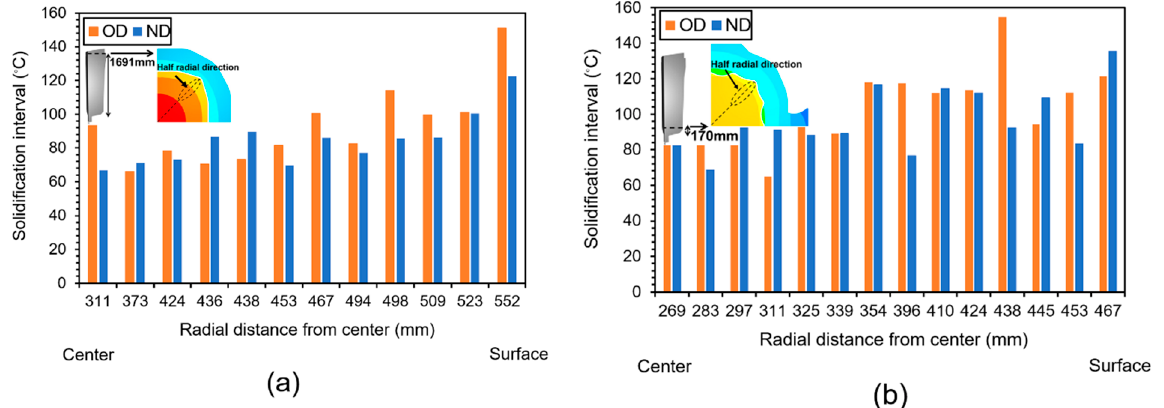
Figure 14. Solidification interval °C in OD and ND at ( a ) A half radial distance from the ingot wall at the hot top area (a height of 1691 mm from the bottom), ( b ) A half radial distance from the ingot wall at the ingot body area (a height of 170 mm from the bottom) .